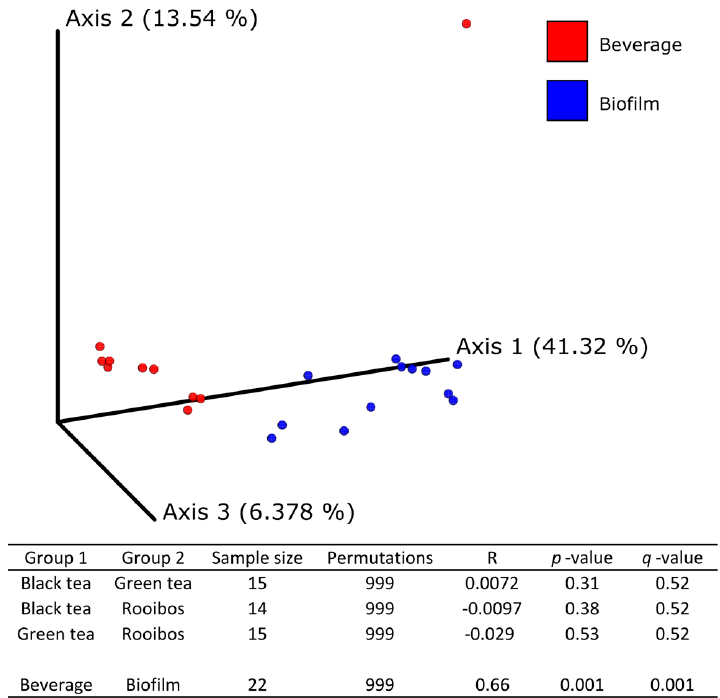
Figure 2. The influence of matrix (plot) and substrate (only table) on kombucha bacterial community structure after 14 days of fermentation illustrated as a PCoA plot. Bray–Curtis dissimilarity index determined by 16S rRNA gene amplicon sequencing (pairwise ANOSIM, 999 permutations). High throughput sequencing of ITS region 2 amplicons obtained 44,795–140,438 paired end reads per samples, with a median of 105,310 after cleaning and quality control check. The fungal community of both biofilm and kombucha (Figure 3, Tables S4 and S5) was dominated by the phylum Ascomycota, in particular, by the family Pichiaceae (>60% and >91%, respectively), with an unidentified Pichiaciae Dekkera spp., as the main abundant